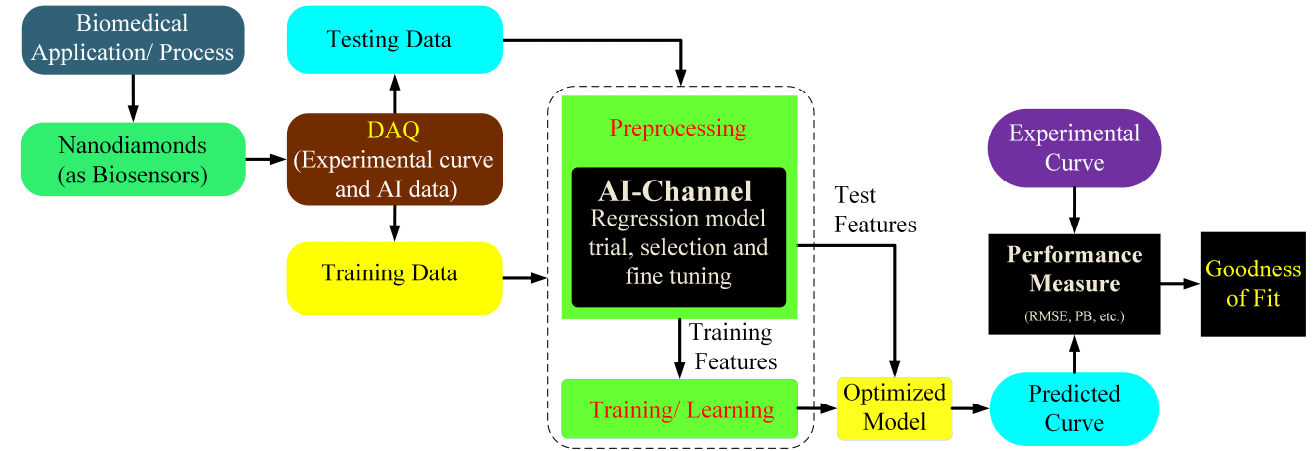
Figure 7. Illustration of AI scheme for the assessment and prediction of a biological process (BP). The proposed model relies upon the signal acquired from nanodiamonds which act as sensors providing electrical signals and an interface between BP and the data acquisition process. The accuracy of this model relies upon the comparison of the goodness of fit from the experimental and predicted curve based on root mean squared error values.